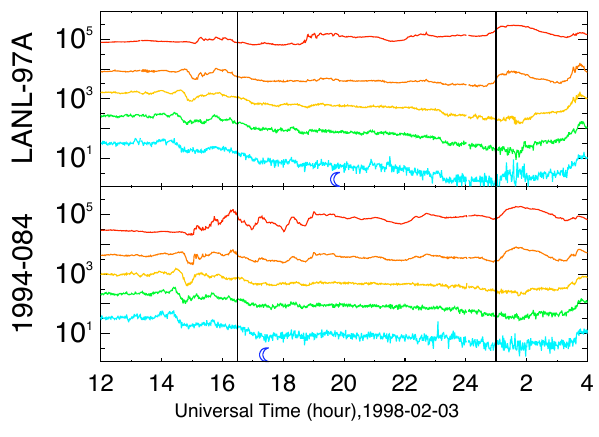
Fig. 2. LANL SOPA Proton data for Event 1. Each color is a different energy channel with red as the lowest energy and blue as the highest. The blue moon represents when the satellite is at local midnight. Once again the vertical lines represent the beginning and the ending of the BRI.